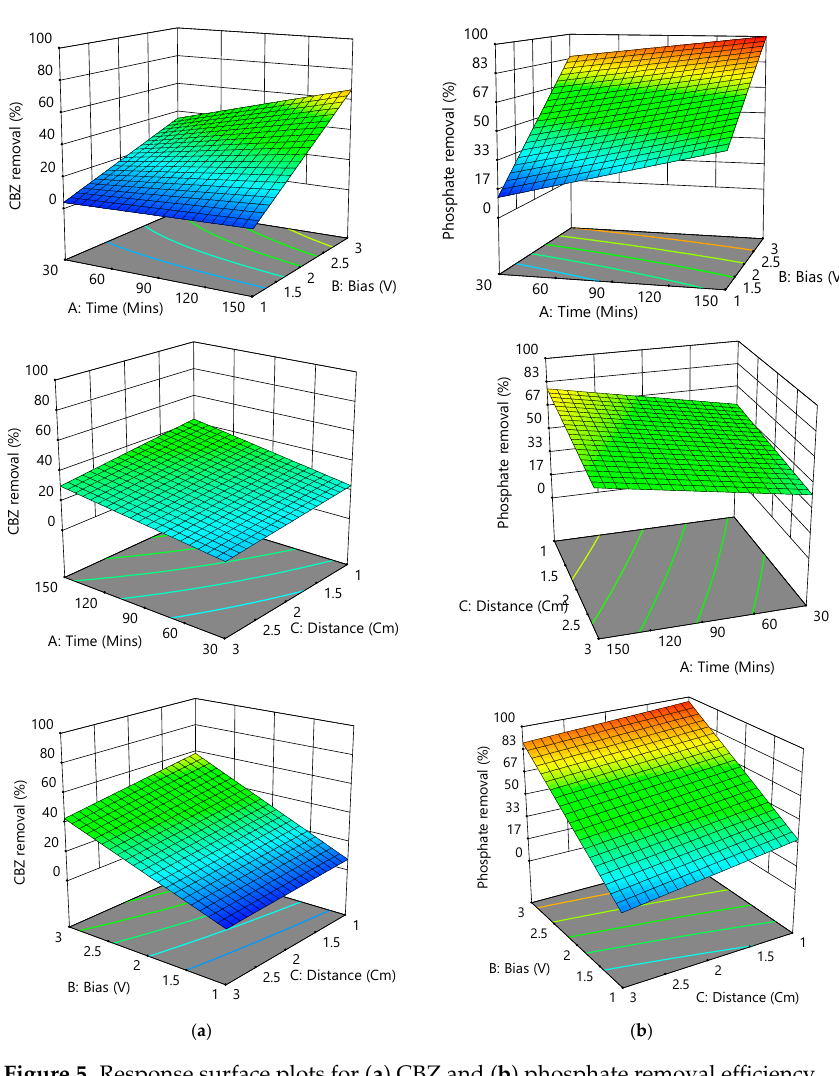
Figure 5. Response surface plots for ( a ) CBZ and ( b ) phosphate removal efficiency.